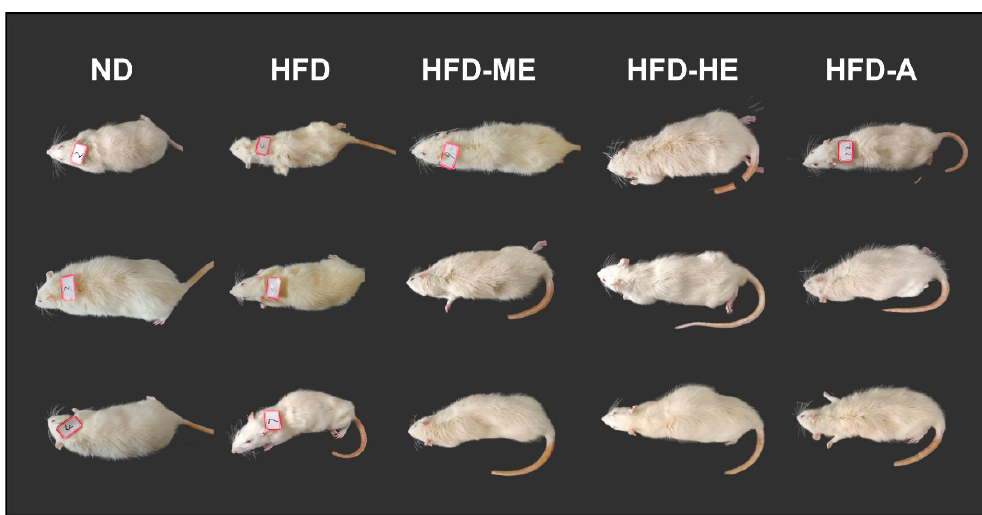
Figure 5. Effect of the ethyl acetate fraction of P. frutescens leaves on the appearance of STZ-induced diabetic rats. ND = normal diet group; HFD = high-fat diet group; HFD-ME = high-fat diet with medium dose extracts group; HFD-HE = high-fat diet with high dose extracts group; HFD-A = high-fat diet with acarbose group.